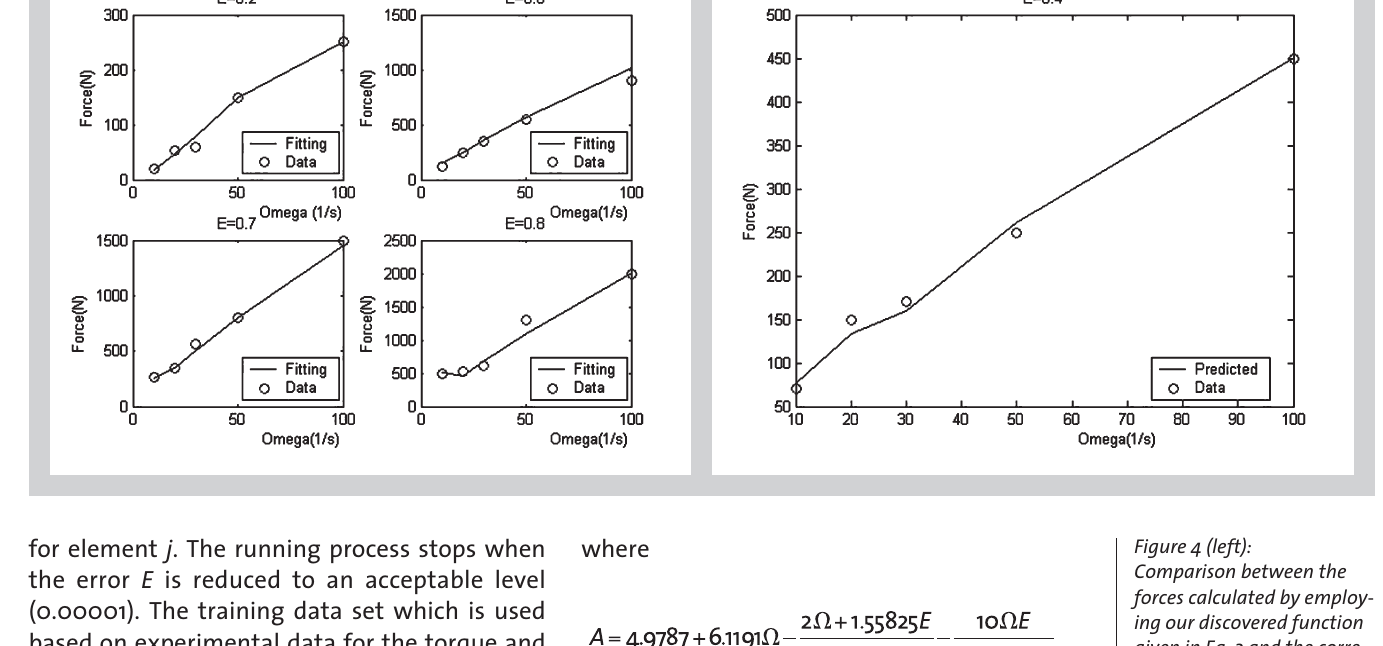
Figure 4 (left): Comparison between the forces calculated by employ- ing our discovered function given in Eq. 3 and the corre- sponding experimental points of eccentricities of 0.2, 0.6, 0.7, and 0.8.